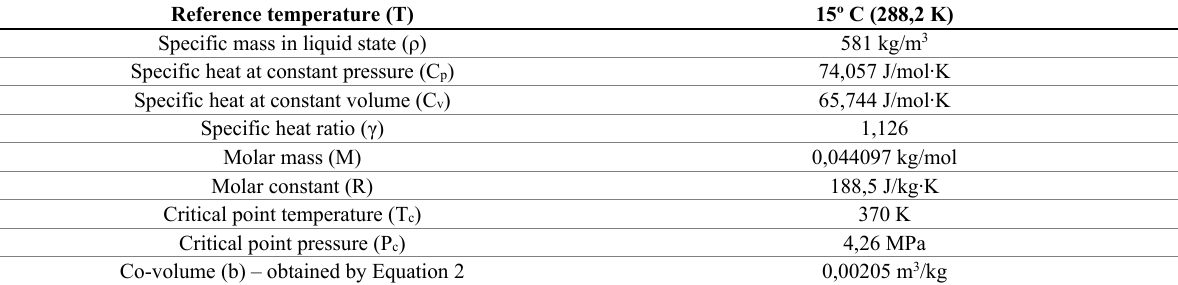
Table 5. Physical and chemical propane gas properties adopted [25] – adapted.